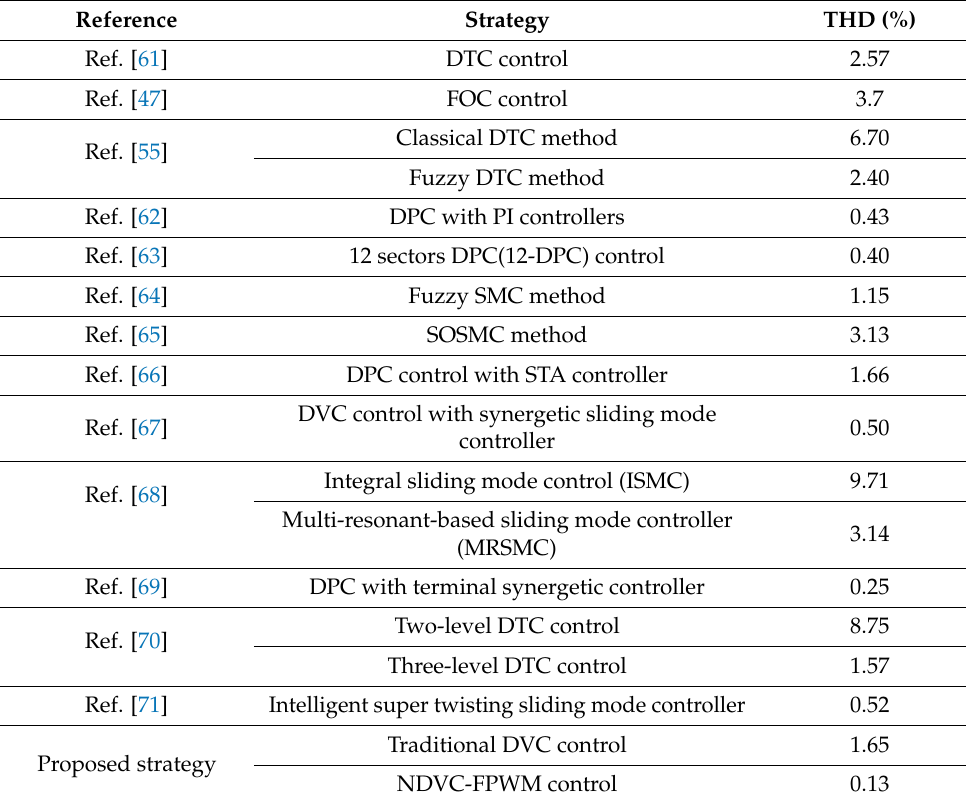
Table 4. Summary table of results obtained compared to other